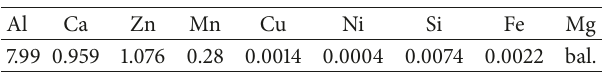
different peripheral roll speeds at a roll temperature of 200 ∘